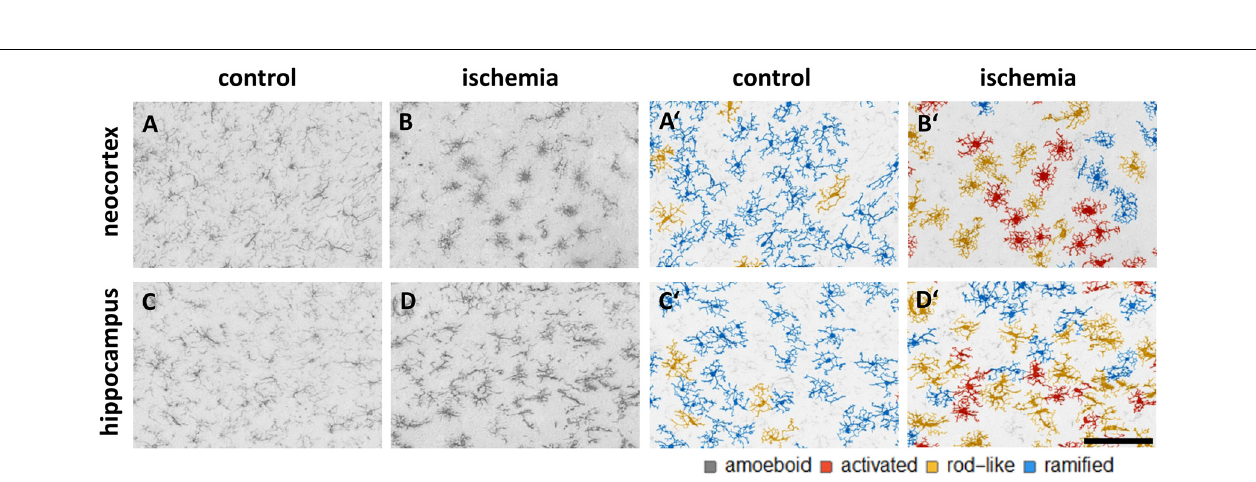
FIGURE 6 | Representative images of Iba1 staining within the control neocortex (A) , ischemic neocortex (B) , control hippocampus (C) , and ischemic hippocampus (D) on the left side, and the appropriate microglial cell segmentation on the right side (A (cid:48) –D (cid:48) ) . Ramified microglia are depicted in blue, rod-like cells in orange, and activated microglial cells in red. Amoeboid microglial cells are not present in the depicted sections due to their low occurrence ( n = 80; see Supplementary Table 2 ).